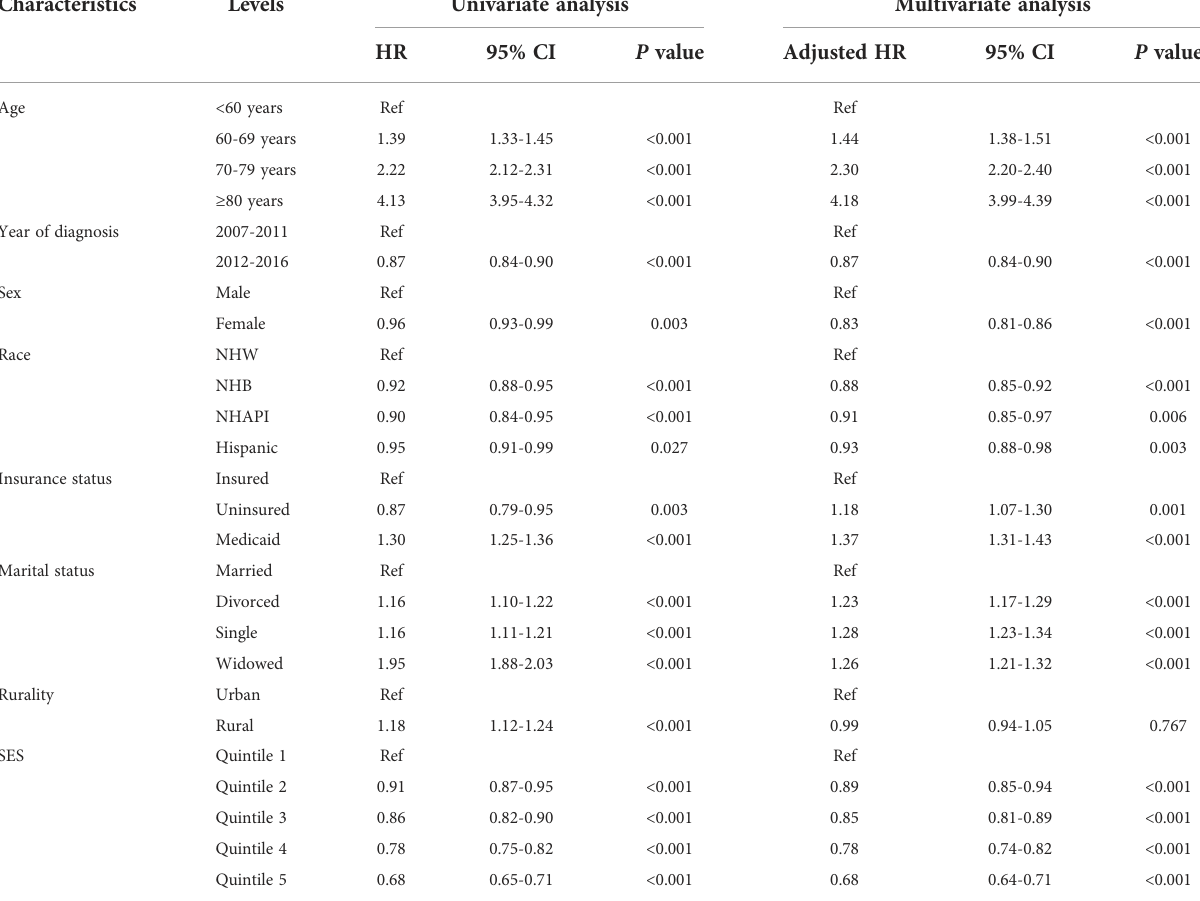
TABLE 2 Univariate and multivariate Cox regression analysis for OS in the SEER cohort.